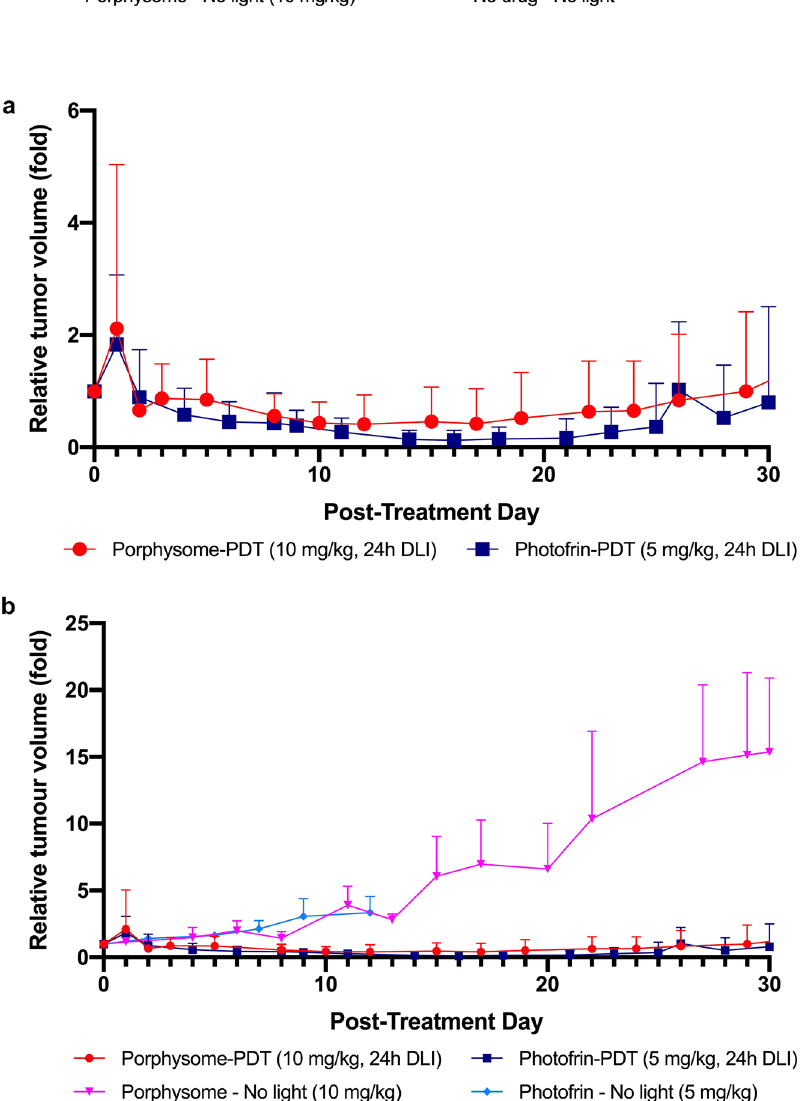
Figure 6: (a) Relative tumor volume for porphysome-PDT (10 mg/kg, 24 h DLI, n = 20) and Photofrin-PDT (5 mg/kg, 24 h DLI, n = 20) with 30 d follow-up post PDT. Mean ± 1 S.D. with half bars shown for clarity. (b) Relative tumor volume for porphysome-PDT, Photofrin-PDT, porphysome-only (10 mg/kg, no light, n = 5), and Photofrin-only (5 mg/kg, no light, n = 5) with 30 d follow-up post PDT. Mean ± 1 S.D. with half bars shown for